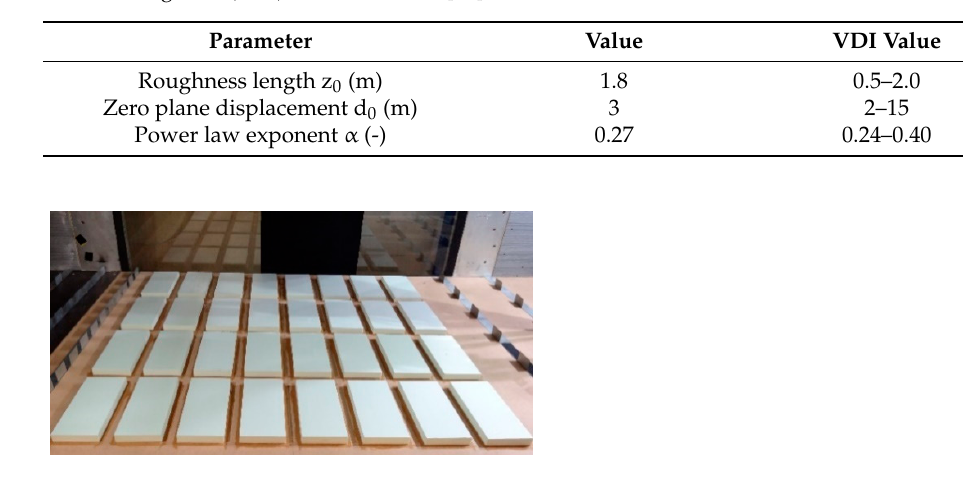
Figure 1. The wind tunnel test section with the